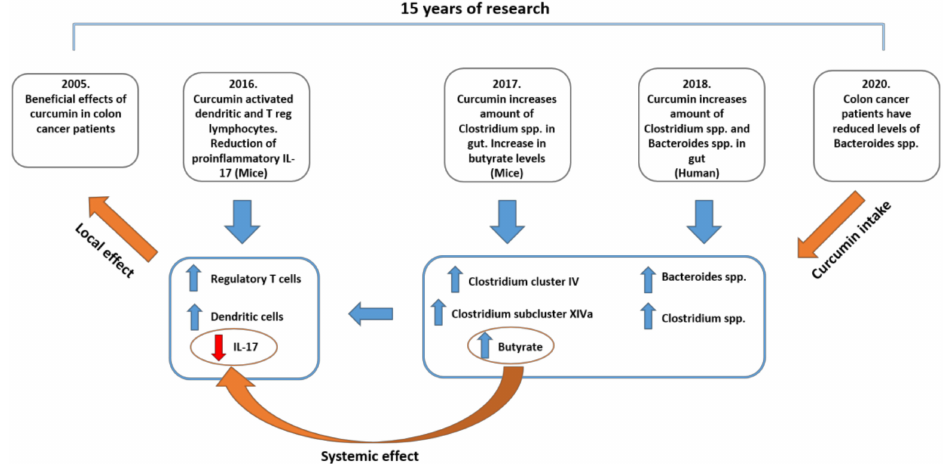
Figure 4. A proposed model for explaining systemic e ff ects consequential to curcumin’s local